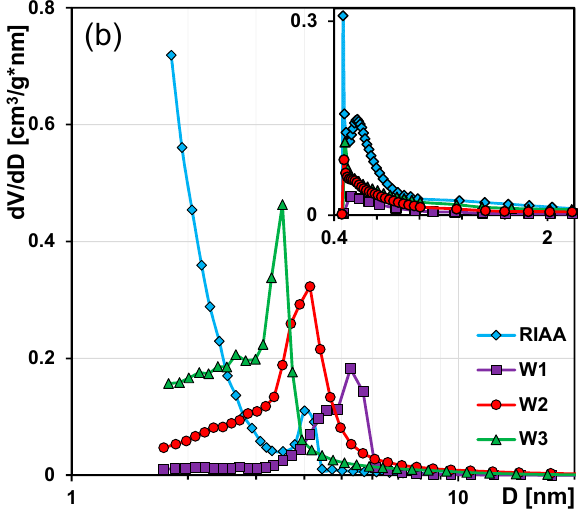
Figure 1. ( a ) The nitrogen adsorption/desorption isotherms for carbonaceous materials. ( b ) Pore size distributions calculated using the Barrett, Joyner, and Halenda BJH and the Horvath–Kawazoe (figure inserted) methods. Table 1. The values of parameters characterizing the porous structure of adsorbents. Carbon